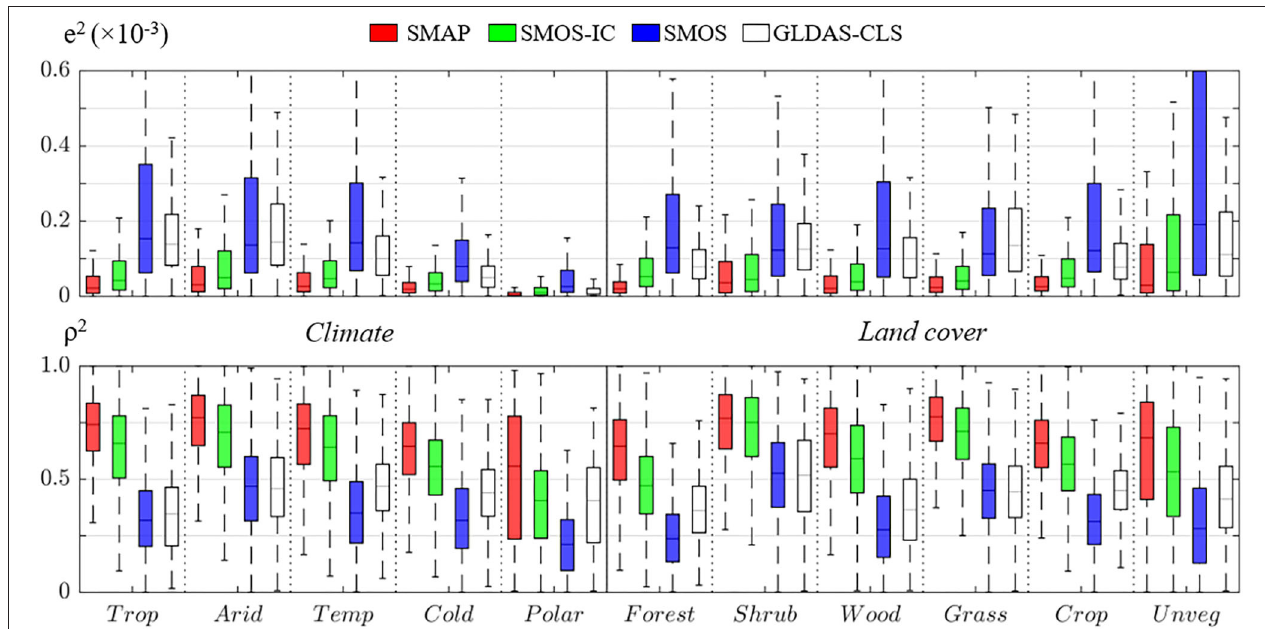
FIGURE 3 | Box plots representing error variances e 2 (Top) and squared Pearson correlation coefficients ρ 2 (Bottom) of SMAP (red), SMOS-IC (green), SMOS (blue), and GLDAS-CLS (white), conditioned by five climate (left), and six land cover classes (right).